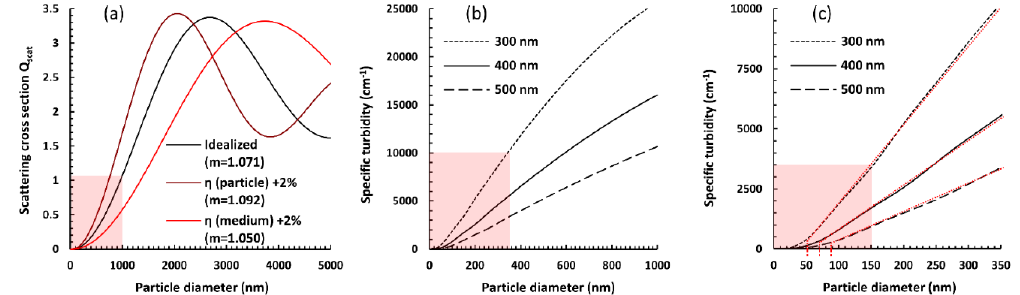
Figure 3. Theory of light scattering on silica particles suspended in ethanol. Pale red sections indicate fragments of the graphs most significant for a further discussion of the specific case described in the paper, which are expanded on in further panels. ( a ) Scattering coefficient Q scat directly calculated using Mie theory; also shown is the large impact of even small deviations in refractive indices on the value and shape of the function. ( b ) Differences in the plots describing the relationship between the particle diameter and specific turbidity, showing that the apparent linearity in the size range is dependent on the wavelength used (expanded shadowed section of (a), with Q scat translated into τ sp ). ( c ) Expanded lower-diameter section (from ( b )), with red dotted lines showing a possible linear approximation and the cut-off point shifting steadily towards smaller particles with a shorter wavelength of incident light. The shadowing in the last panel shows the diameter section crucial for pinpointing this linearity cut-off point, which inspired the third experimental series of nanoparticle syntheses.